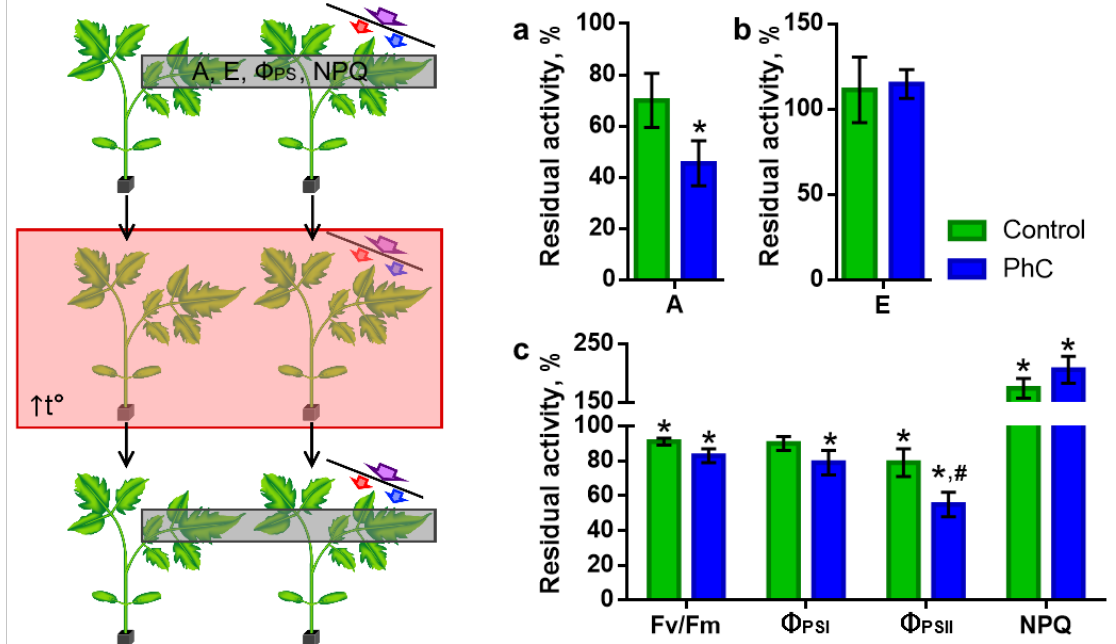
Figure 4. Effect of a photoconversion coating on the resistance of tomato plants to heat stress, which was determined by the residual activity of physiological processes after heating: ( a ) residual activity of assimilation; ( b ) residual activity of transpiration; ( c ) residual activity of light-driven photosynthesis reactions. Residual activity is expressed in percentages, where 100% corresponds to the level before HS. The measurement scheme is shown on the left. Photosynthesis levels were first recorded (gray rectangle in the scheme); then, plants were subjected to heat stress for 45 min at a temperature of 46 °C (red rectangle in the scheme). The residual levels of photosynthesis were recorded 1 h after heat stress. A: assimilation of СО 2 ; Е : transpiration; F v /F m : efficiency of PSII photochemistry; Ф PSI and Ф PSII : quantum yield of photochemical reactions of photosystems I and II; NPQ: non-photochemical quenching of fluorescence; PhC: photoconversion. *: the difference between “after HS” and “before HS” is significant, p < 0.05; #: the difference between “control” and “photoconversion” is significant, p < 0.05.